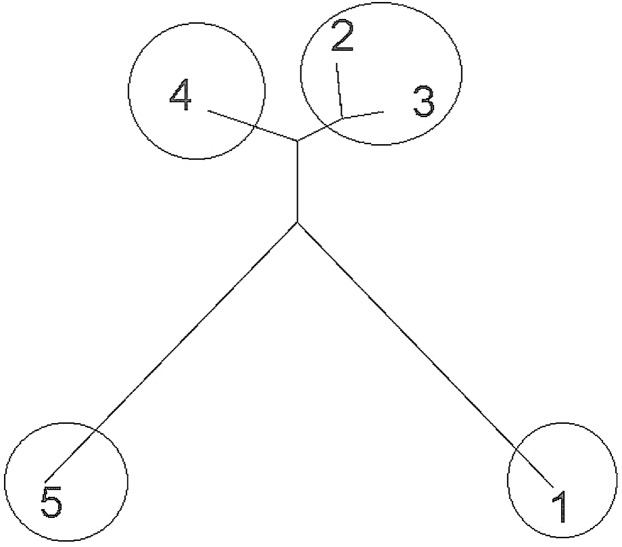
Tree plot scheme of five engaged populations of P. canius.